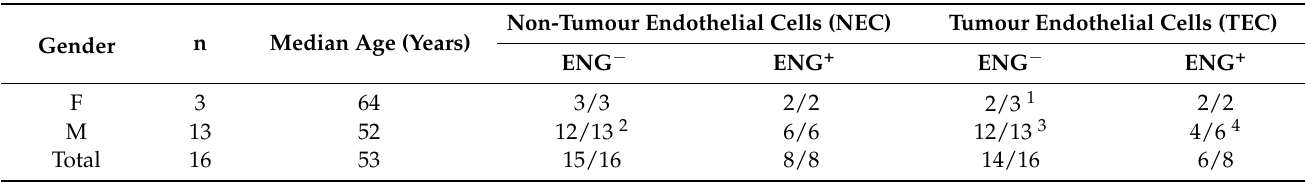
Table 1. Characteristics of the study cohort. Numbers before the slash represent the number of used samples, numbers after the slash represent the number of total